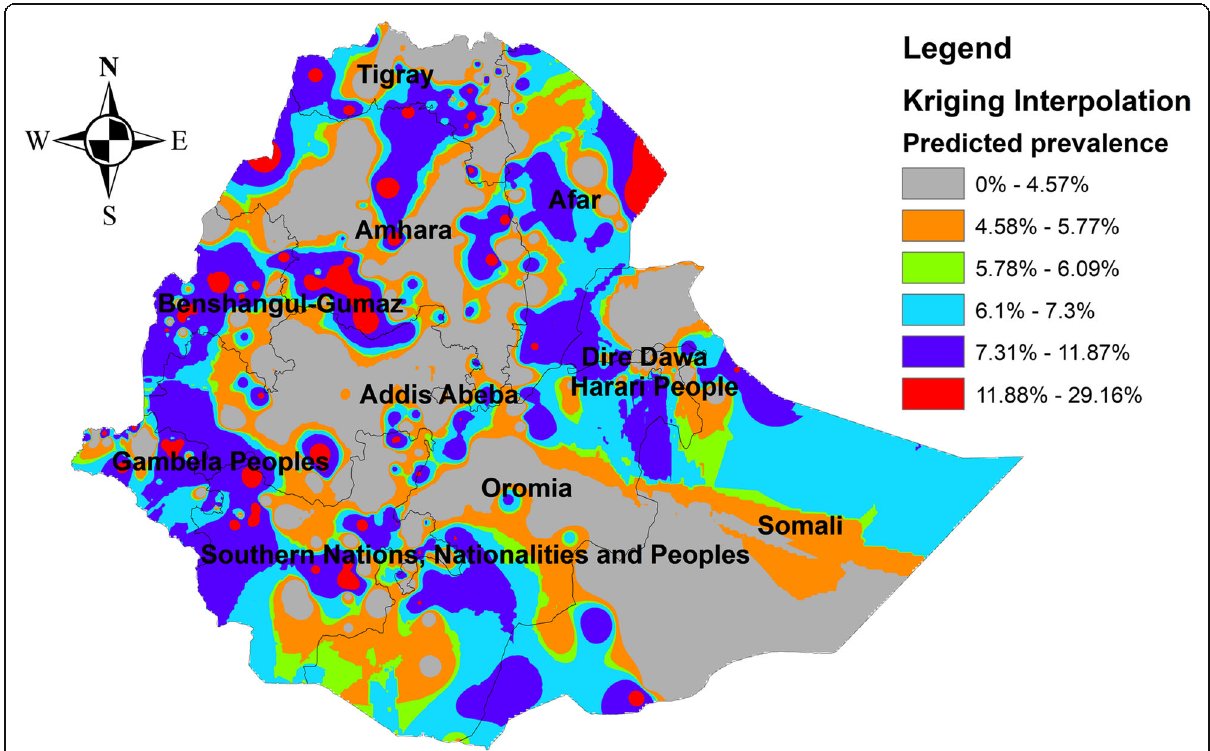
Fig. 8 The Kriging interpolation of infant mortality in Ethiopia